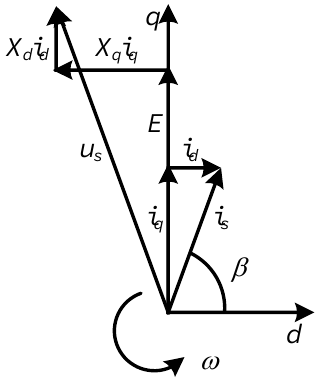
Figure 2. The voltage – current model of a PMSM.